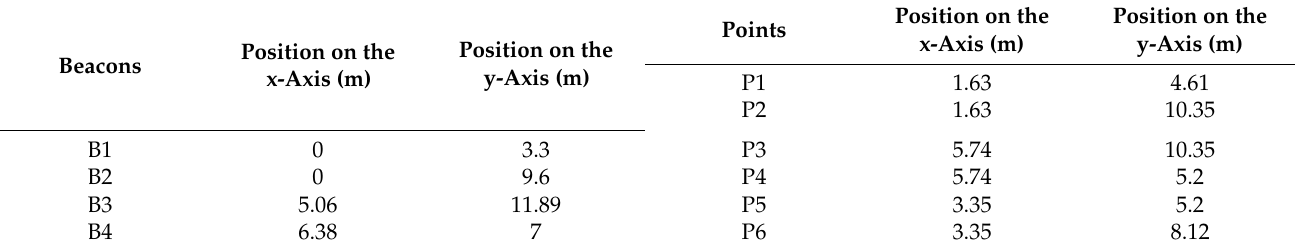
Table 2. Real Location of the beacons and